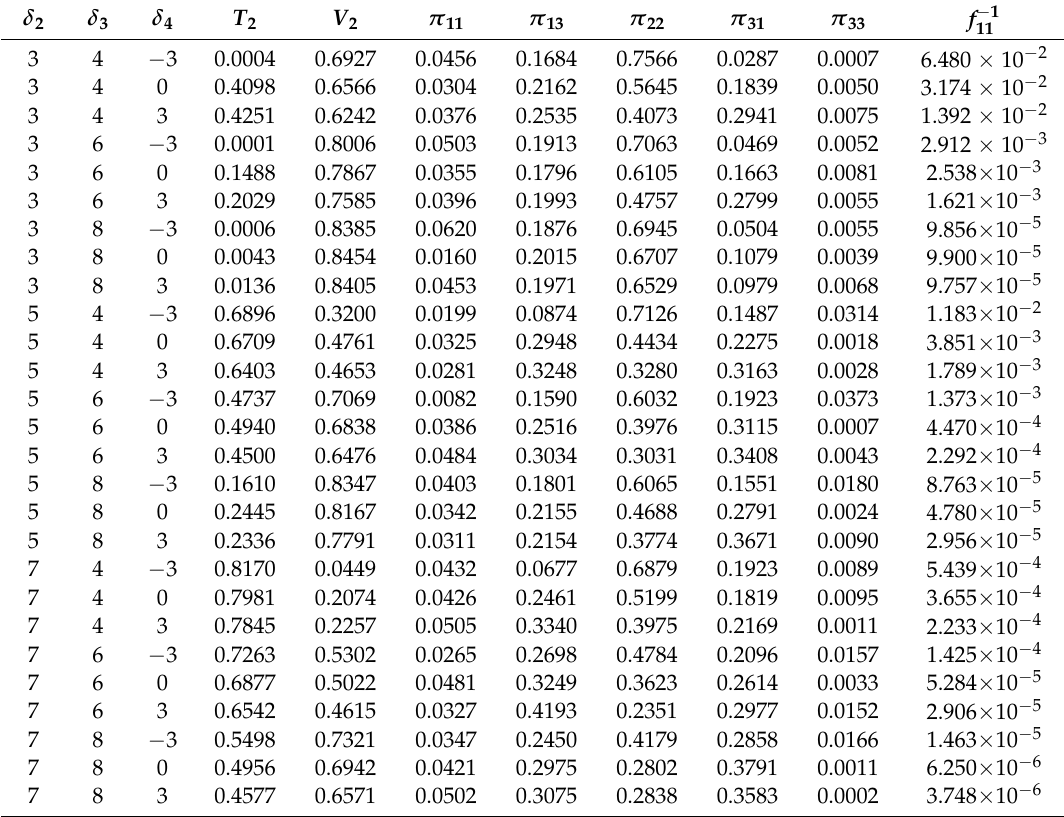
Table 3. The practical PADT plans with two stress